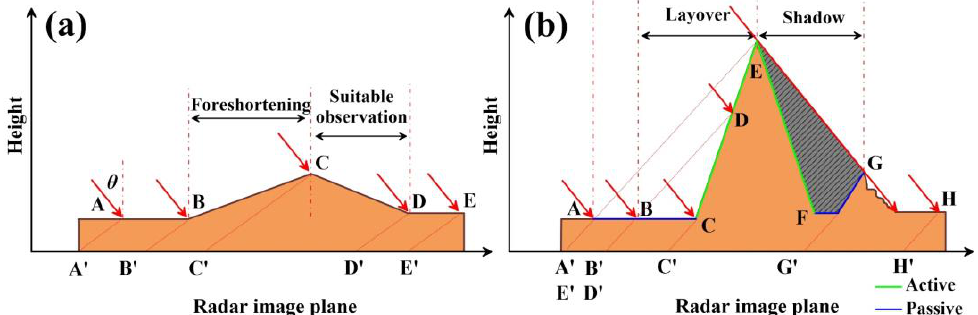
Figure 3. ( a ) Principle of foreshortening and suitable observation. ( b ) Principle of layover and shadow. The blue line indicates passive distortion and the green line indicates active distortion (adapted from [41]).